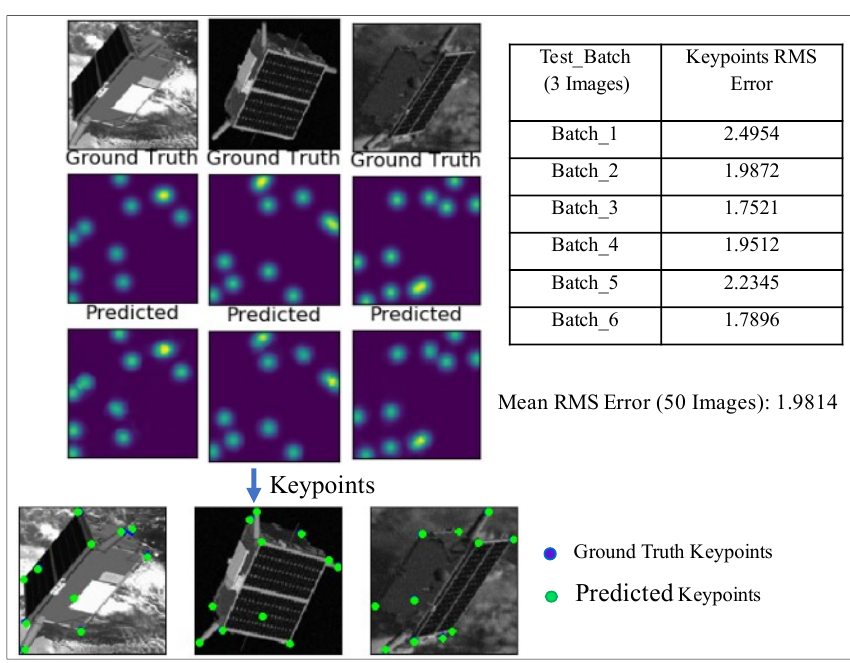
Figure 12. Performance of ResNet34-U-Net on Keypoint Localization.